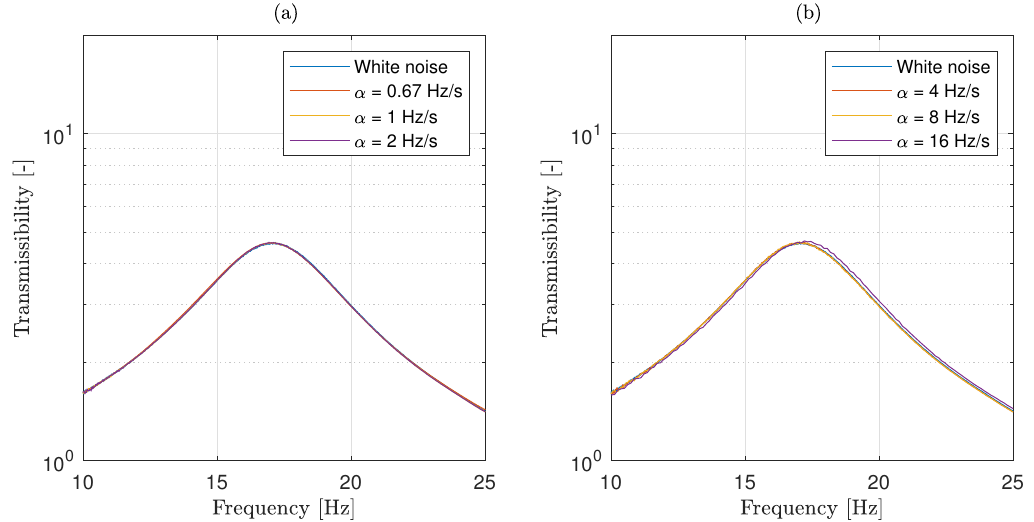
Figure 5. Comparison of the transmissibility obtained using a white noise excitation with those obtained using a sweep sine excitation for the elastomer case, for slower sweep rates ( a ) and faster sweep rates ( b